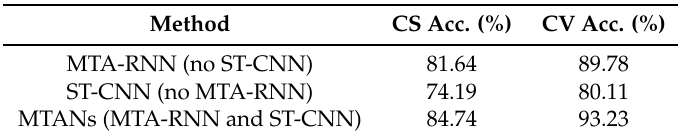
Table 2. Comparison of ablation experiment results on the NTU RGB+D dataset, which demonstrated the performance of MTA-RNN (Multi-Term Attention Recurrent Neural Network) and ST-CNN (Spatio-Temporal Convolutional Neural Network). CS: Cross-Subject; CV: Cross-View.